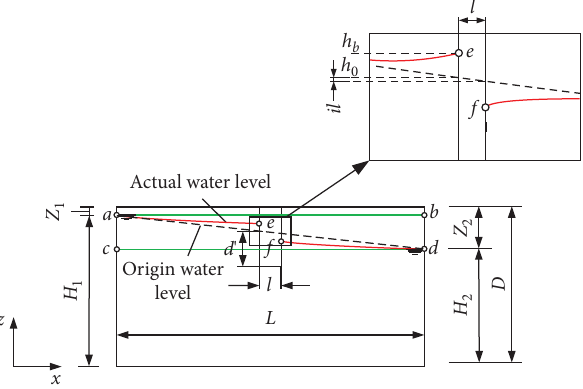
Figure 8: Schematic of underground water level